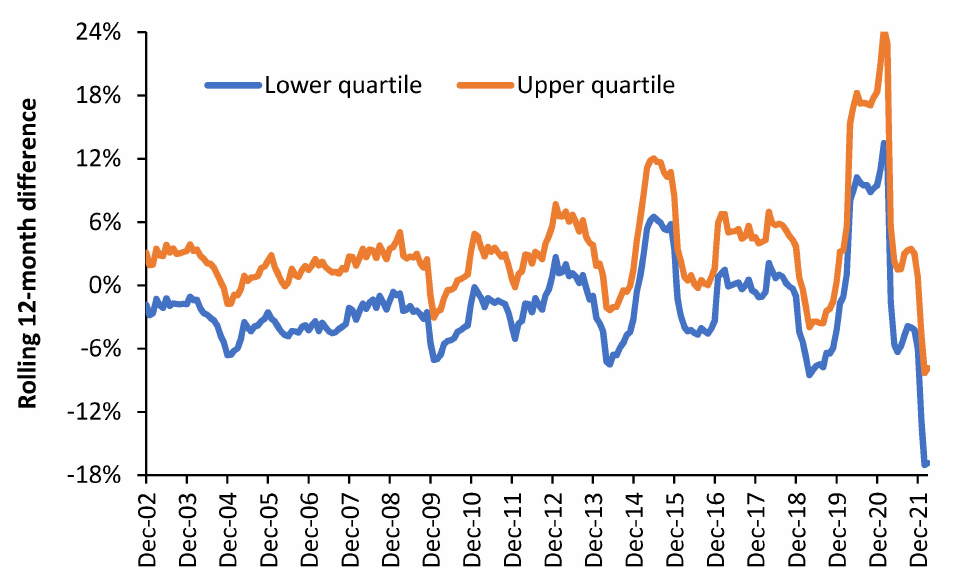
Figure 5. Lower and upper quartile for the rolling/moving 12-month difference in total deaths (all-cause mortality) in 516 UK local government areas and regions, 2001 to